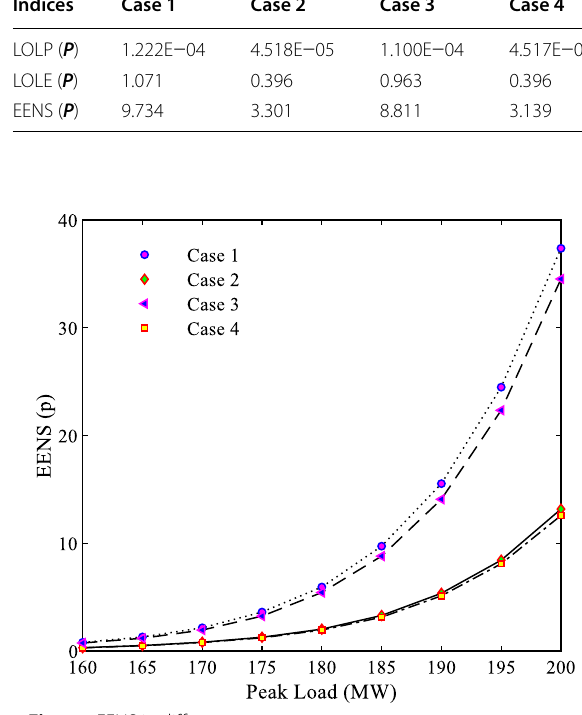
Fig. 13 Critical peak rebates in different cases